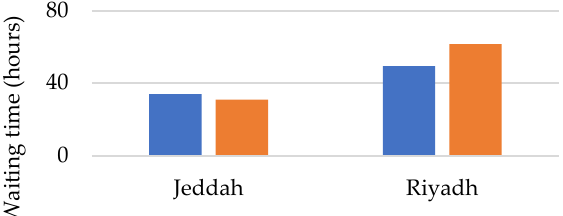
Figure 13. Comparing truck waiting time for S5A and S5B.